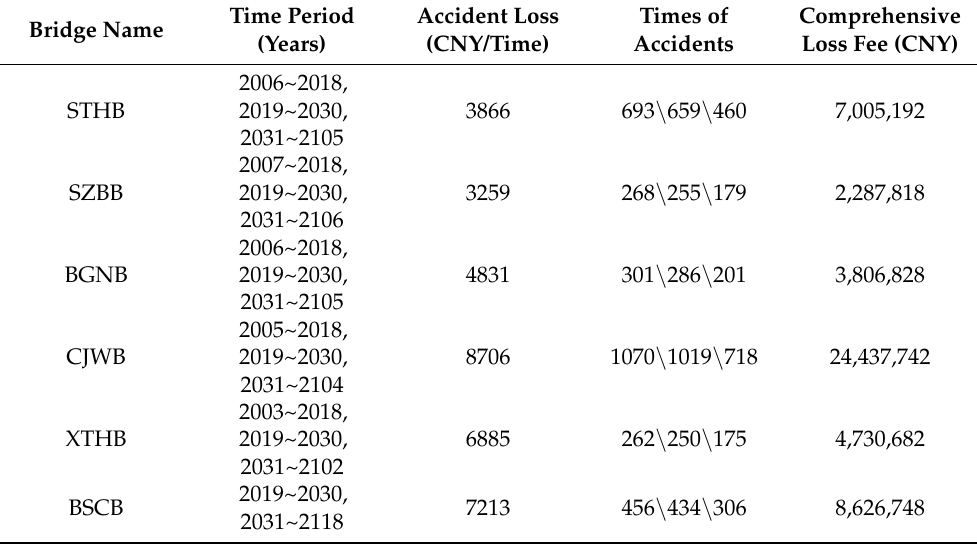
Table 5. Statistical table of loss from traffic accidents of six bridges during operation